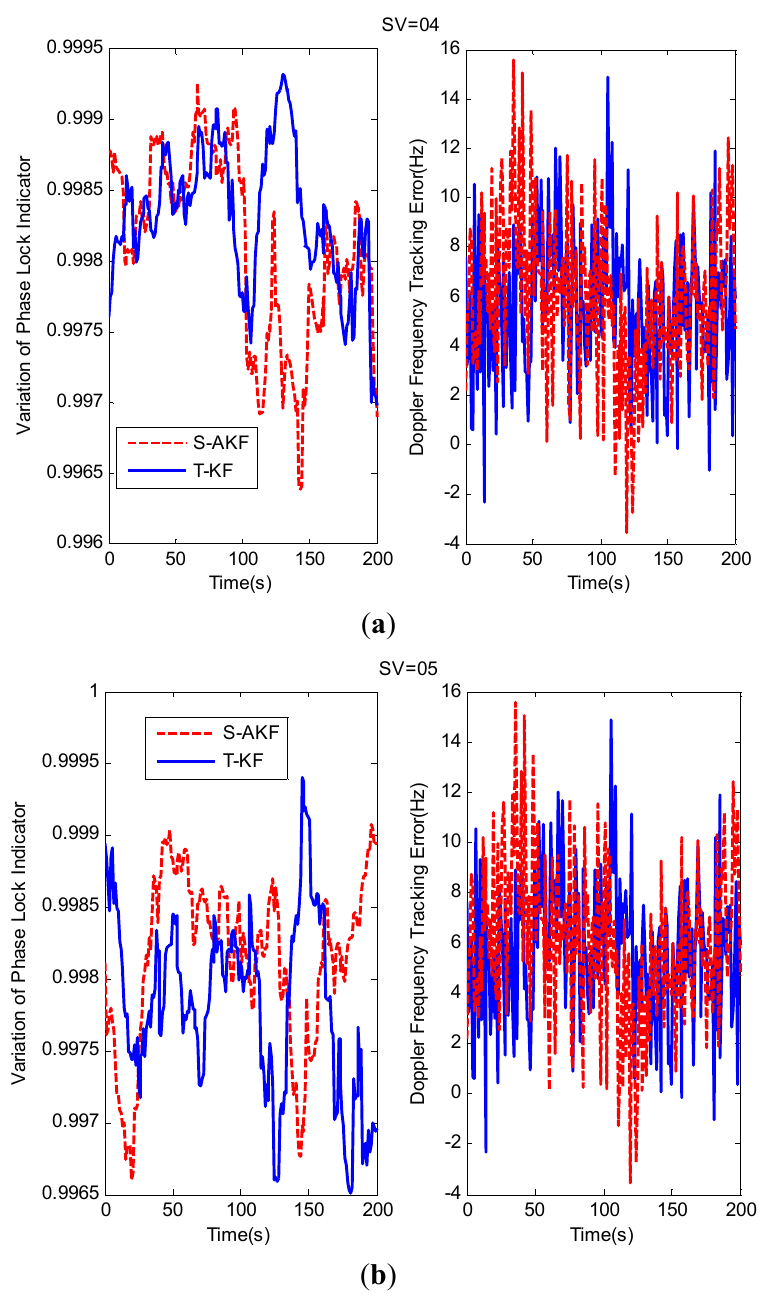
Figure 7. ( a ) Tracking performance comparison for SV04; ( b ) Tracking performance comparison for SV05.